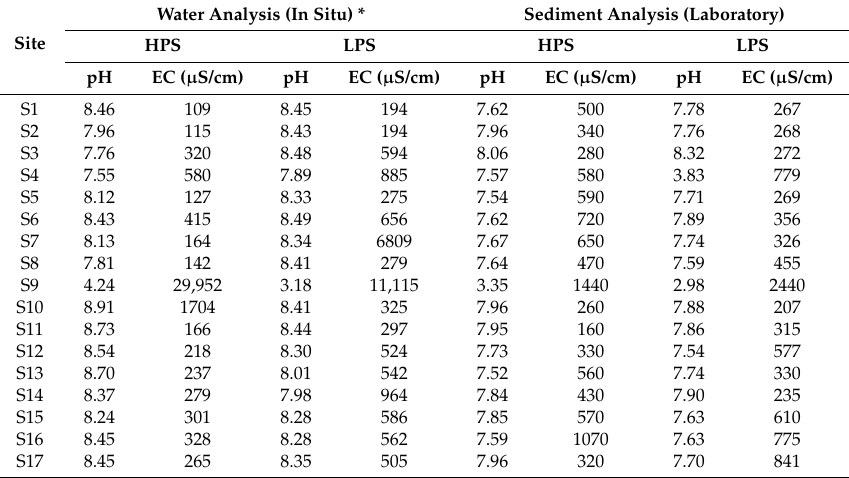
Table 4. Variation of chemical properties (pH and